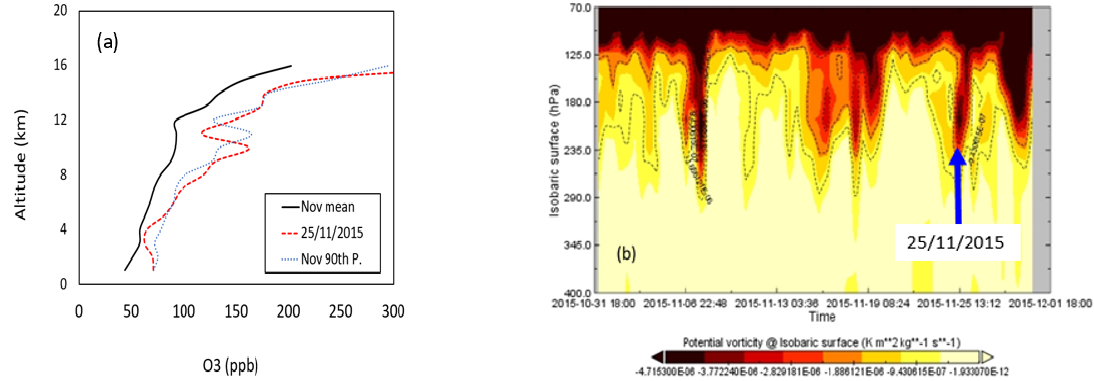
Figure 10. ( a ) Ozone troposphere profile over Irene on 25 November 2015. ( b ) Potential vorticity at Isobaric surface over Irene on July 2004 (from MERRA-2). Solid line in Figure 10a indicates monthly O 3 average composite, broken line indicates O 3 event and dotted line indicate 90th percentile composite. Colours in Figure 10b indicates the level of potential vorticity, black indicates high potential vorticity of more than 3 Km − 2 kg − 1 s − 1 while yellow indicates potential vorticity of less than 2 Km − 2 kg − 1 s − 1 . Blue arrow in Figure 10b indicates the event that is associated with O 3 profile in Figure 10a.